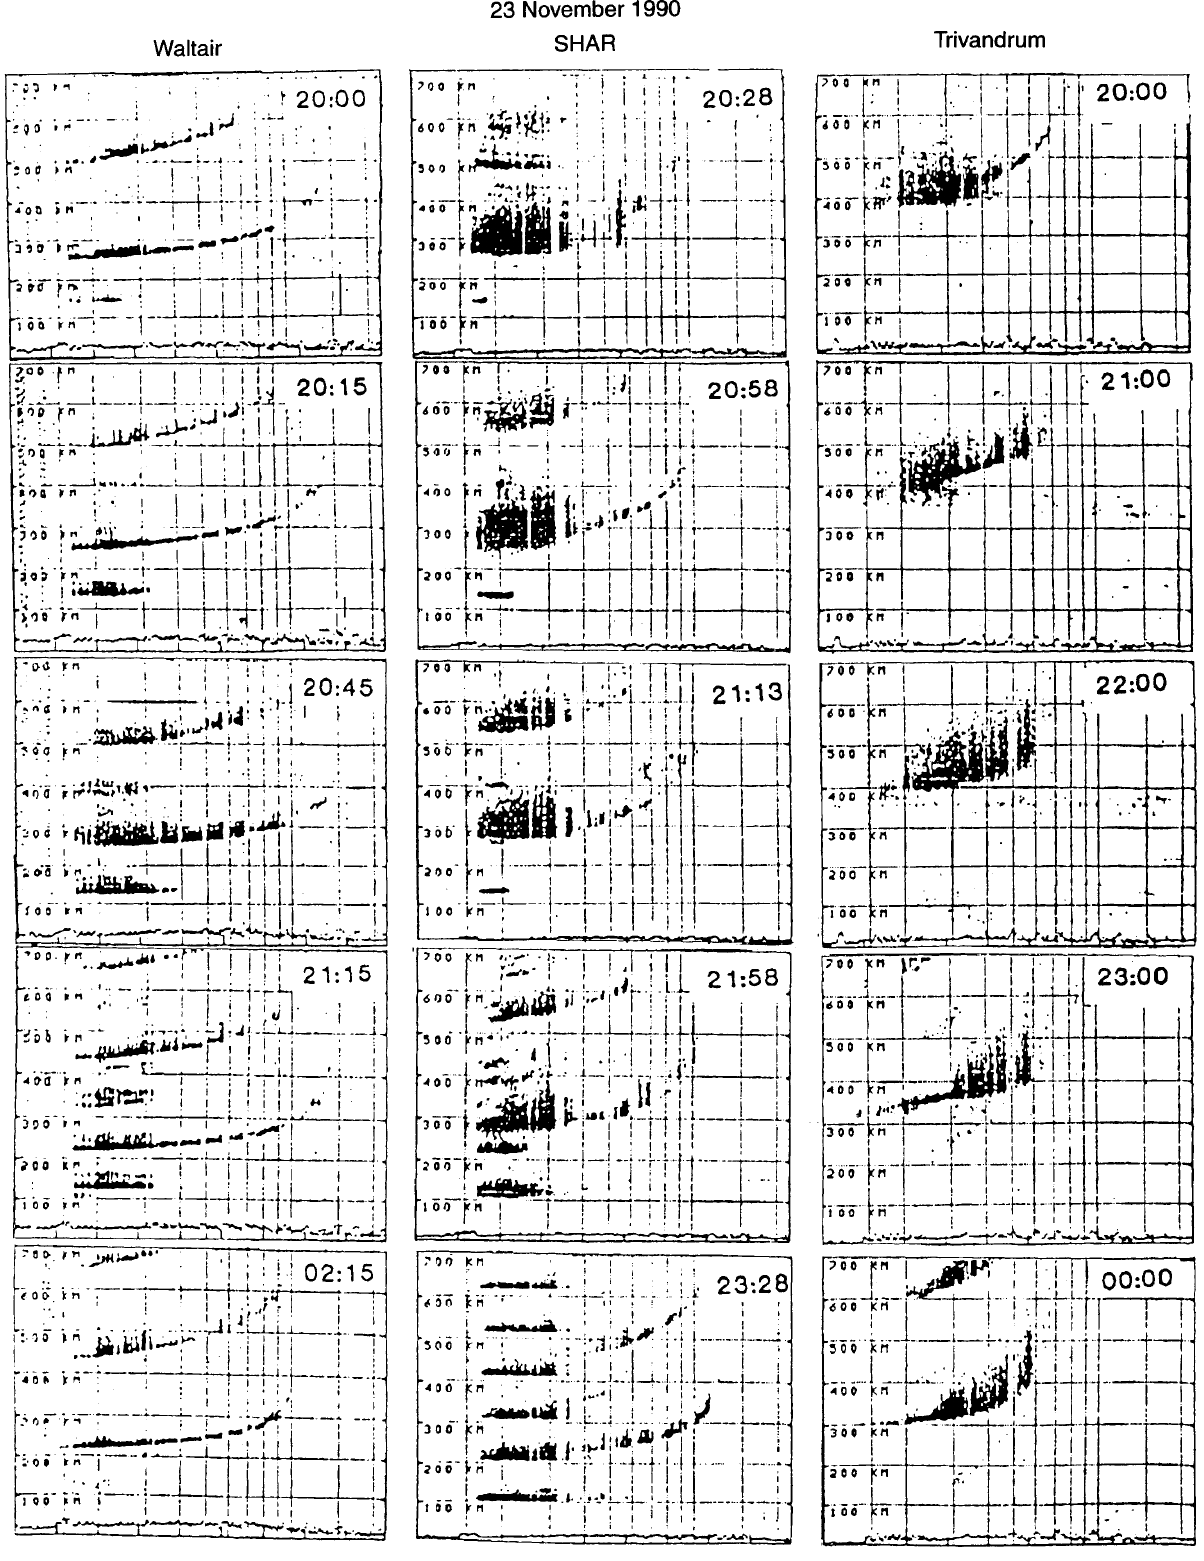
Fig. 1. Ionograms showing the descending Es layers at Waltair and SHAR during the night of 23 November, 1990. The ionograms at an equatorial station, Trivandrum is also shown for the same day, but the layer was not observed at